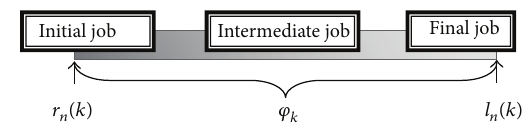
Figure 3: Work done by other tasks in 𝜑 𝑘 . Table 3: Capsules used timer ports and